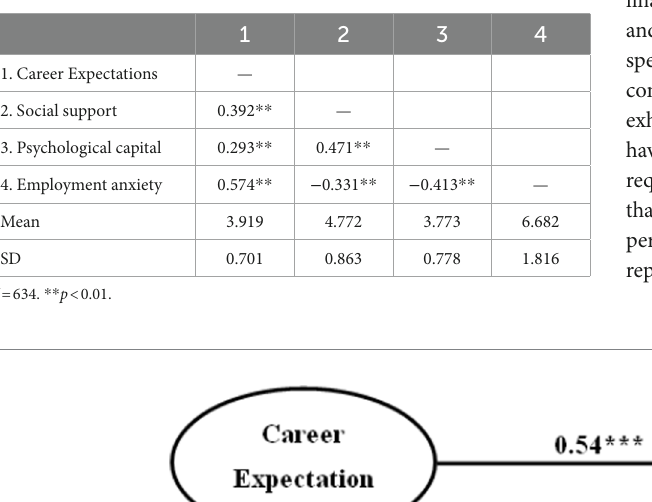
TABLE 1 Descriptive statistics and correlations of study